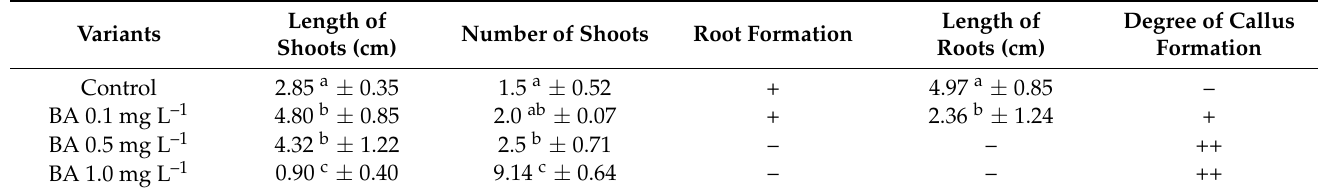
Table 1. Influence of BA on length and number of shoots, root formation and callogenesis of in vitro propagated V. caucasica . Length Variants